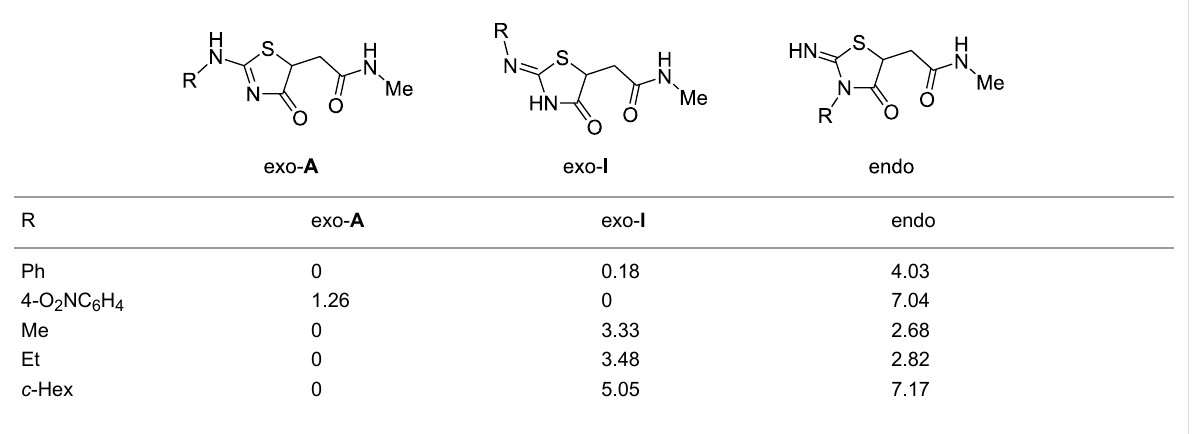
R exo- A exo- I Ph